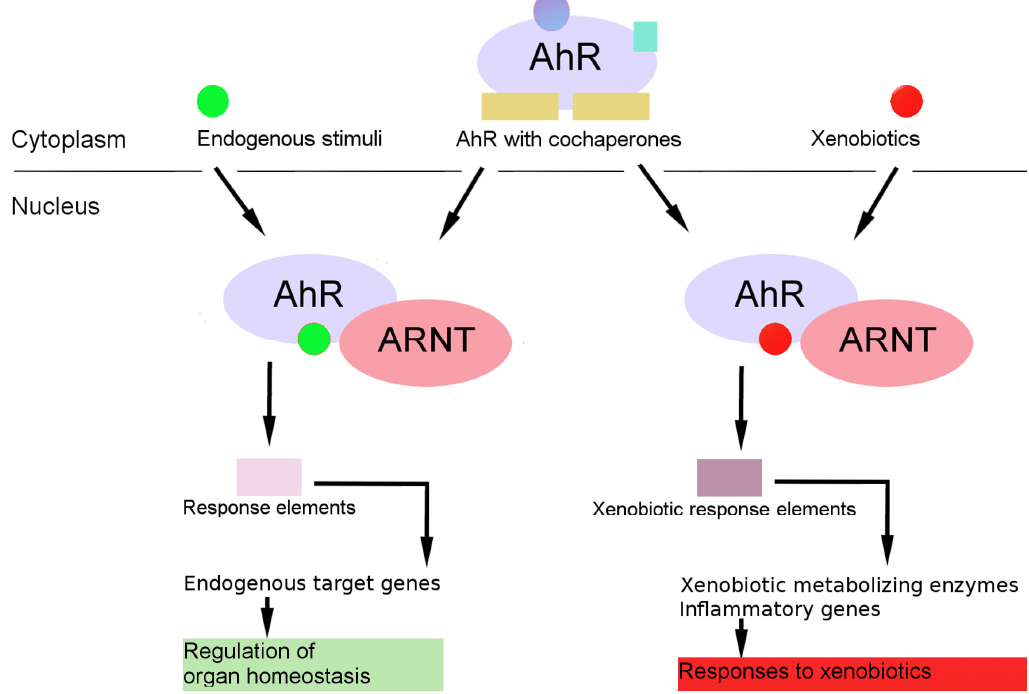
Figure 2. The AhR genomic pathway. AhR resides in cytosol in a complex of chaperones and other proteins. Upon ligand (xenobiotics or endobiotics) binding, AhR changes conformation. This allows